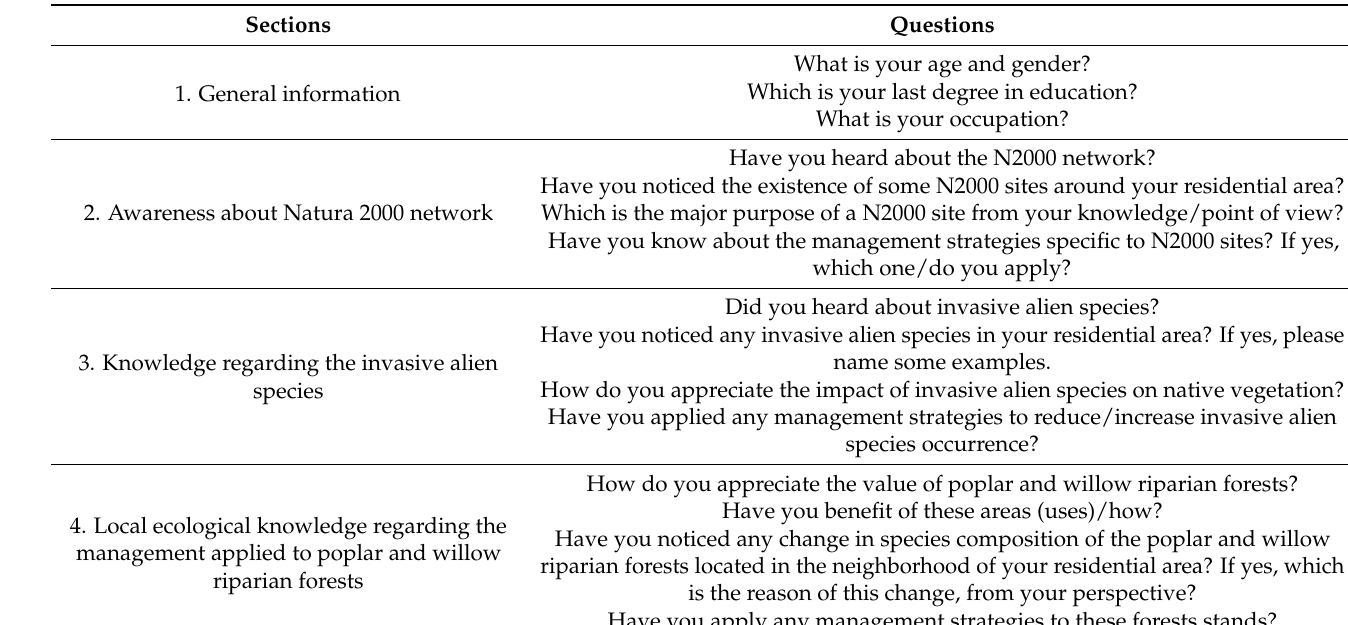
Table 1. The questions addressed through semi-structured